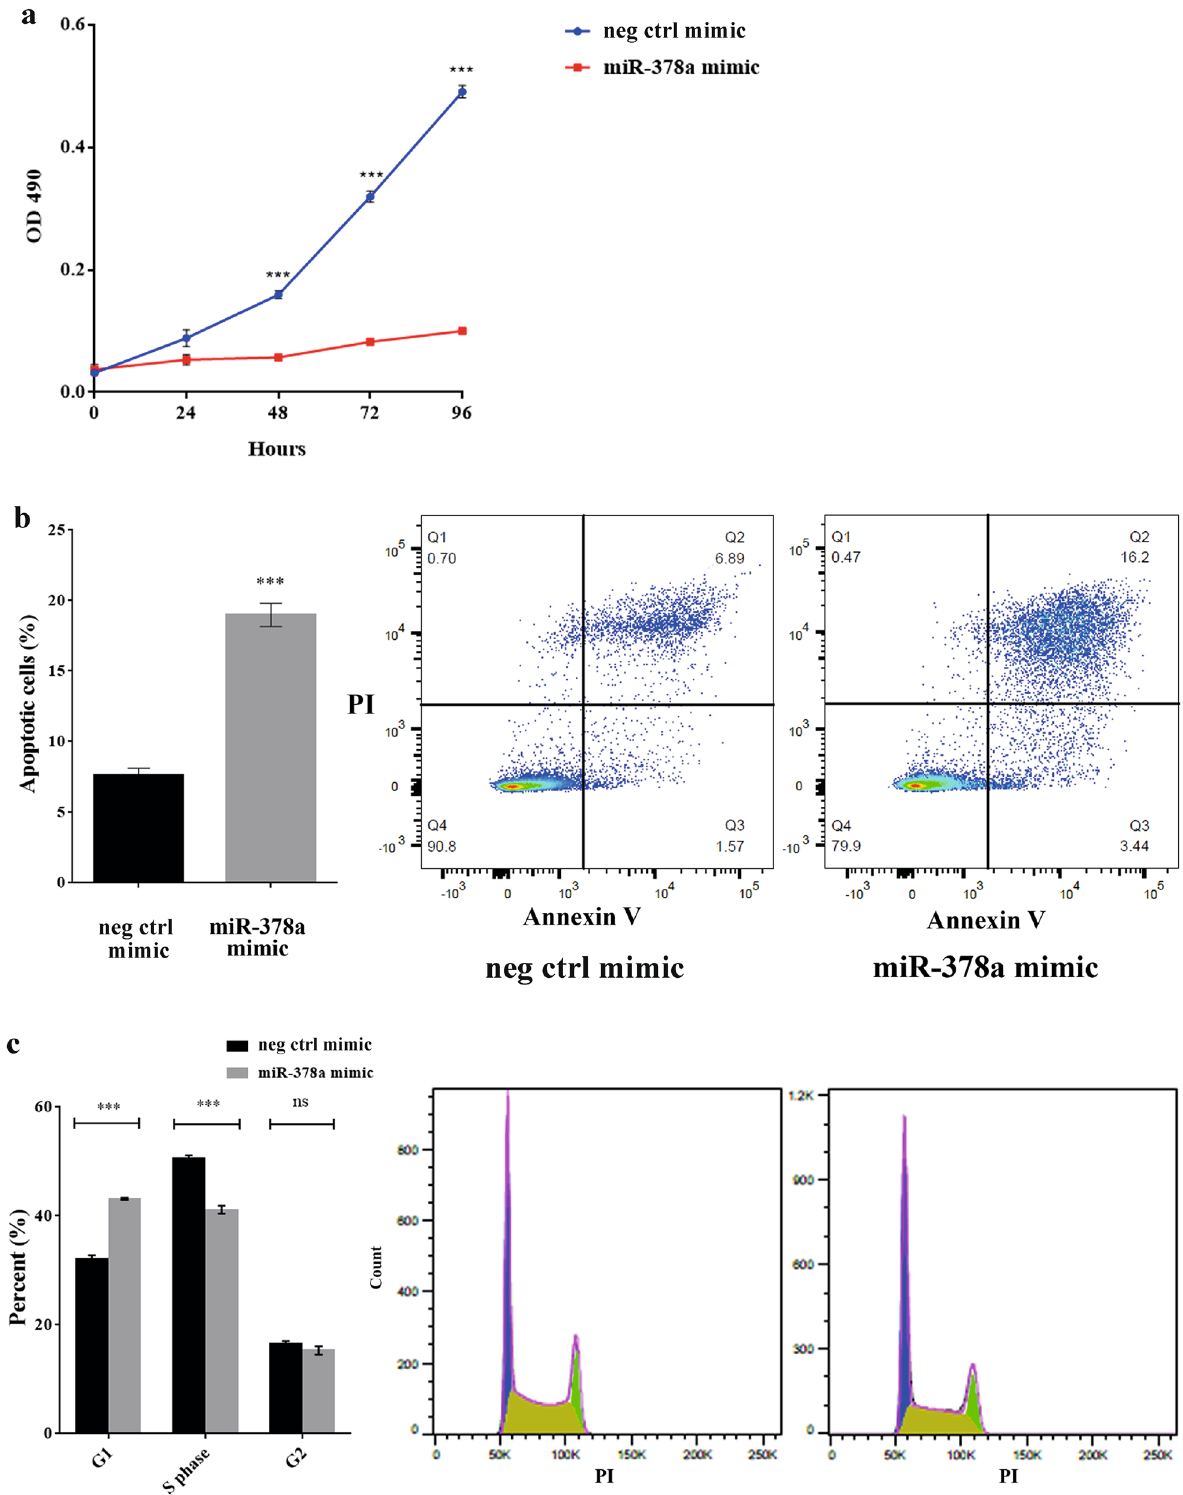
Figure 2. miR-378a diminished cell proliferation in NHEK cells, leading to increased apoptosis and cell cycle arrest. ( a ) The proliferation analysis of NHEK cells transiently expressing miR-378a for 24, 48, 72, and 96 h as measured by MTS assay. ( b ) The percentage of apoptosis keratinocytes after transfection with miR-378a for 72 h. The bar chart shows an average percentage of apoptotic cells calculated from three independent flow cytometry-based apoptosis assays. The dot plots illustrate the necrotic cells (Q1), late apoptotic cells (Q2), early apoptotic cells (Q3), and live cells (Q4). ( c ) The percentage of NHEK cells over-expressing miR-378a for 72 h at different cell cycle phases (G1, S, and G2). The bar chart shows an average of the percentage of cells calculated from three independent cell cycle assays as measured by flow cytometer. The histograms display a representation of cell cycle phase distribution in cells over-expressing miR-378a or negative control mimic. Error bars indicate mean ± SEM from three replicates, ****indicates P < 0.0001, ***indicates P < 0.001, and ns indicates non-significant. Neg ctrl mimic = negative control of